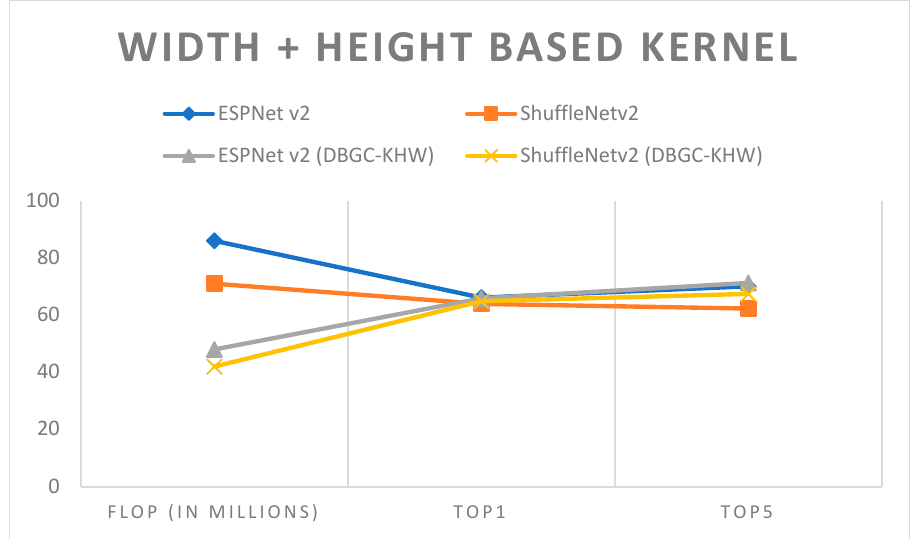
Figure 20. Depth+height-based kernel. Figure 20. Depth + height-based kernel.